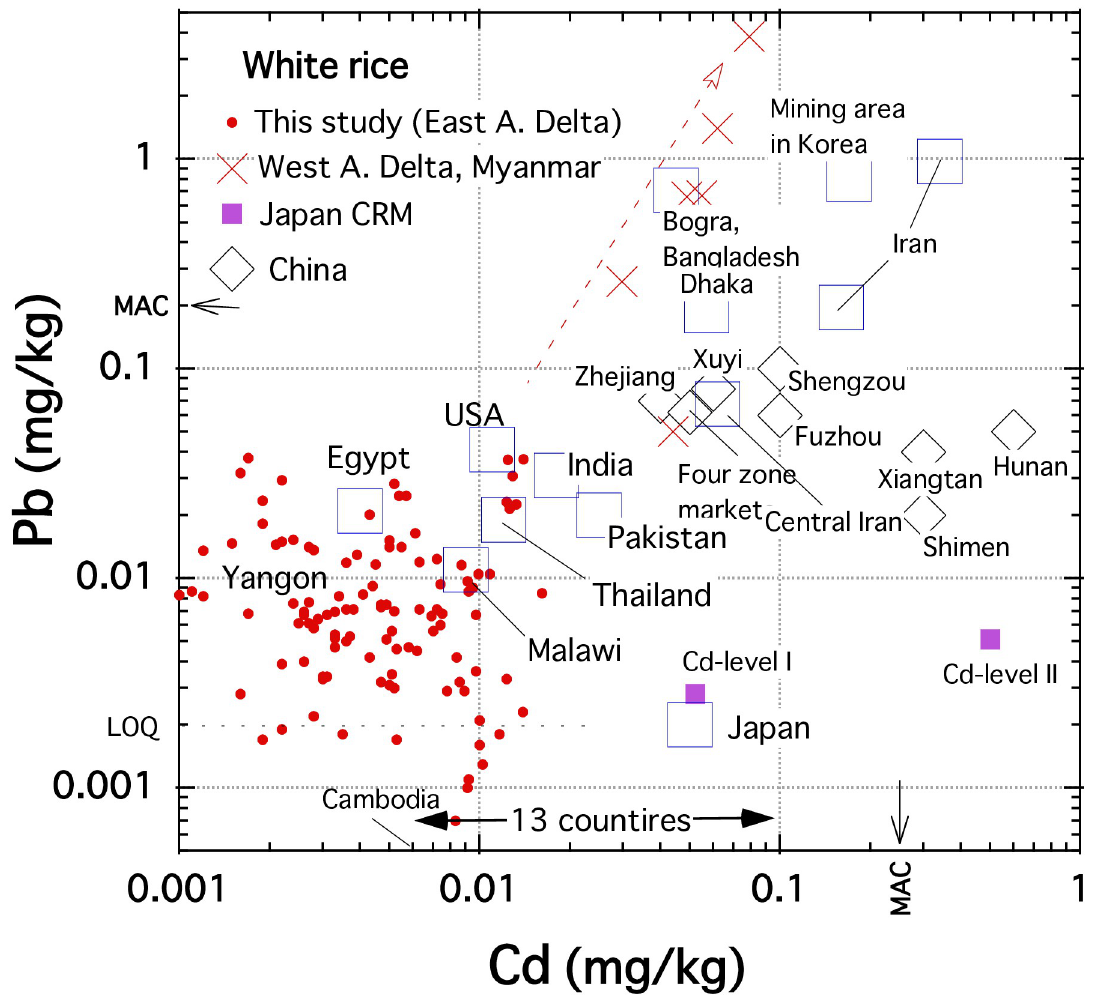
Fig 4. Correlation diagram between Pb and Cd concentrations in white rice from different countries and areas. Japanese certified reference materials (CRM) data are from S2 Table. The mean values of previous reports: West Ayeyawady delta in Myanmar [20,